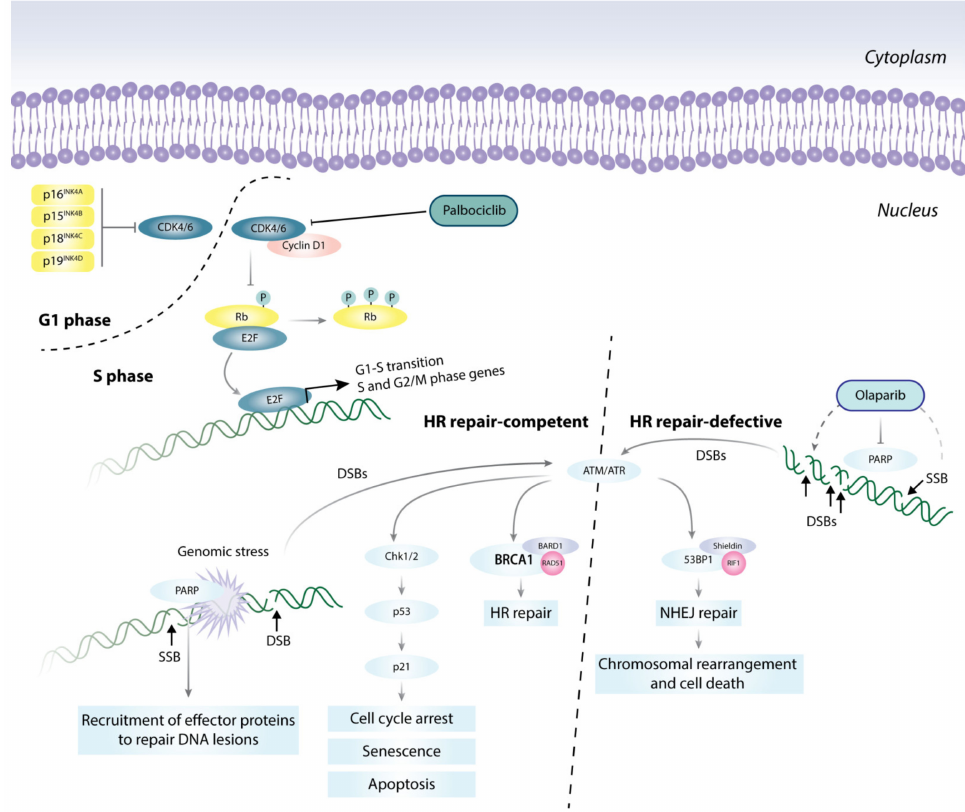
Figure 2. Targeted therapies directed at cell cycle and DNA damage repair pathways. Pro-growth stimuli promote the formation of the CDK4/6-cyclin D1 complex, which phosphorylates and inac- tivates the tumor suppressor Rb, and releases E2F. E2F then initiates a transcription program that supports G1-S phase transition. Genomic stress activates DNA damage response (DDR) mechanisms, e.g., ATM/ATR, and PARP signaling pathways, and triggers the Chk1/2-p53-p21 axis to induce cell cycle arrest, senescence, or apoptosis as a means to halt the propagation of genetic lesions. Accumulation of DNA double-stranded breaks (DSB) can be repaired by two mechanisms: (1) the error-free homologous recombination, HR; or (2) the error-prone non-homologous end-joining, NHEJ. FDA-approved PARP inhibitors, e.g., Olaparib, when used with standard treatments, can force HR repair-defective cells, such as in BRCA1 mutant cells, to activate the error-prone NHEJ pathway, lead- ing to genomic instability beyond repair and causing cell death. BARD1 (BRCA1-associated RING domain protein 1); RIF1 (Rap1-interacting factor 1 homolog); and 53BP1 (TP53-binding protein 1). CDK4/6 inhibition effectively reverses drug resistance to endocrine therapies and RTK- based therapies. A screening of 47 breast cancer cell lines revealed that CDK4/6 inhibition suppresses the growth of ER + luminal cancer and HER2 + cancer cell lines by inhibiting RB phosphorylation. More importantly, in combination with tamoxifen, palbociclib also resensitizes resistant MCF7 cells to tamoxifen [190]. Miller and colleagues have shown that chronic deprivation of estrogen can lead to the hyper-activation of the PI3K/AKT signaling pathway and sustained CDK4-E2F activation, thus causing estrogen resistance in breast cancer cells [191]. Consistently, a combinatorial drug screen of 42 compounds found that CDK4/6 inhibition exhibits the most significant synergism with PI3K inhibitors (BYL719 and GDC-0941) in a panel on PI3K-mutant breast cancer cell lines (T47D, MCF7, and MDA-MB-453) resistant to PI3K inhibition [192]. Molecular studies found that high levels of pRB S780 may contribute to the resistance to PI3K inhibition in resistant cells in vitro, and in derived xenograft models. In agreement with this, combinatorial use of the CDK4/6 inhibitor LEE011 plus BYL719 or GDC-0941 caused tumor regression in breast cancer xenograft models